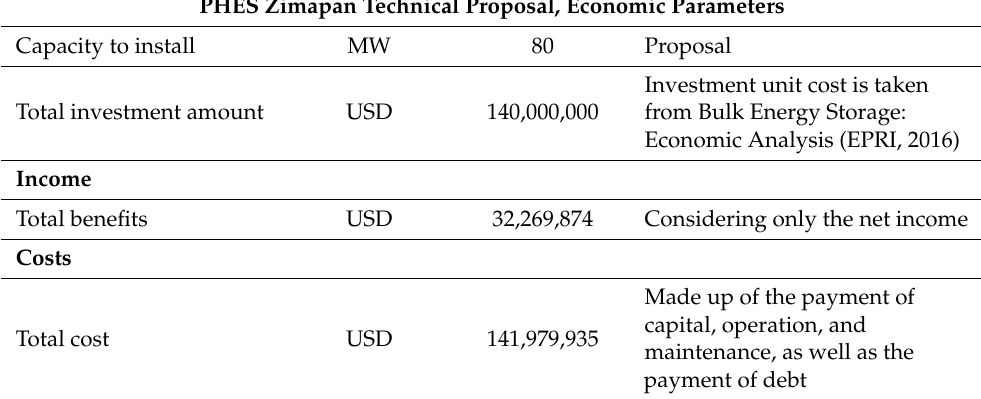
Table 10. PHES Zimapán economic parameters.